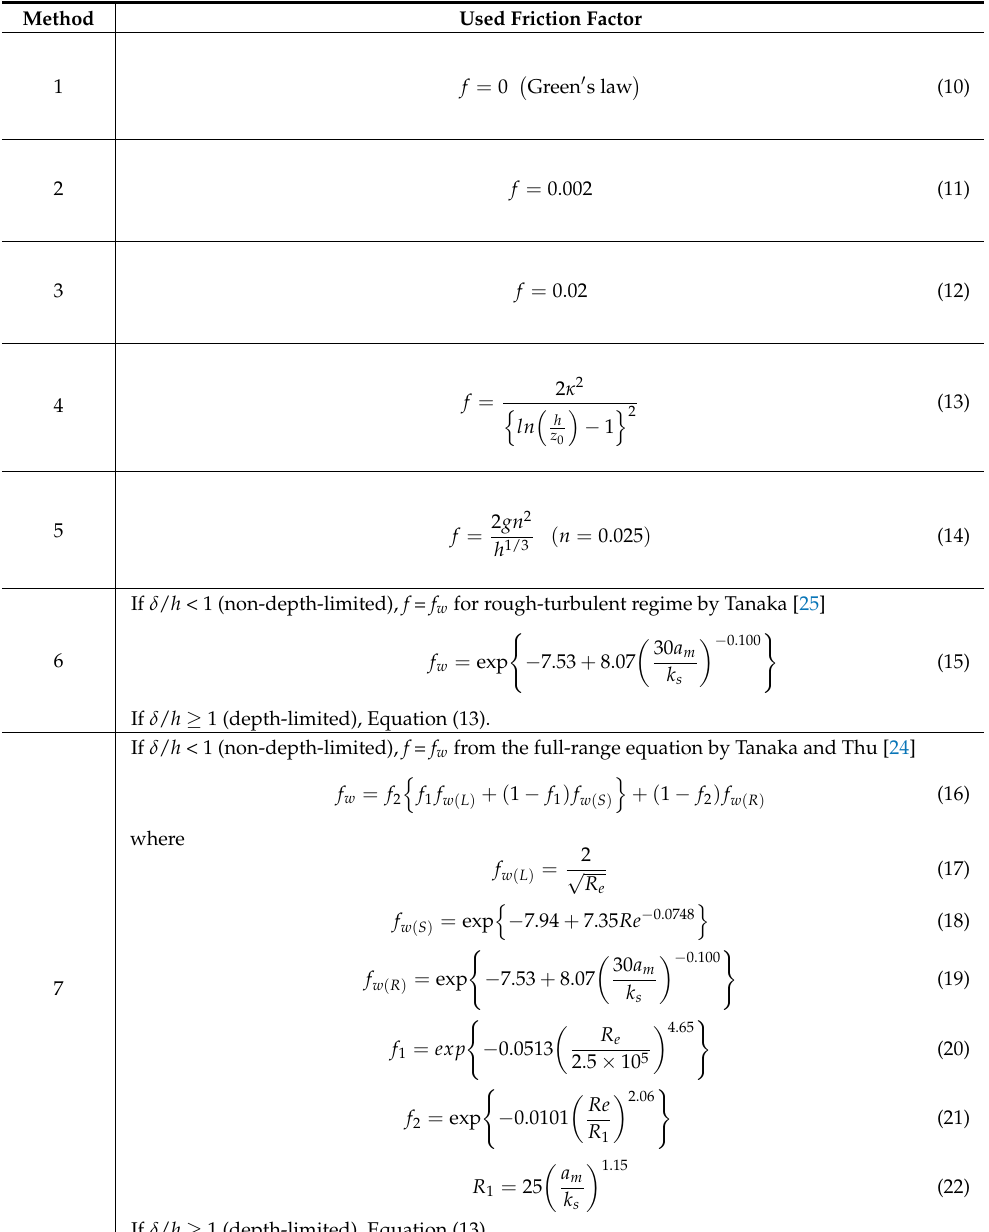
Table 1. Friction coefficients used to integrate Equation